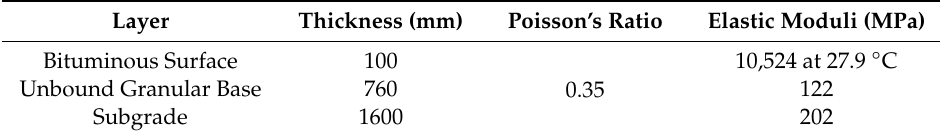
Figure 4. On-site installation of sensors in the pavement structure. Table 1. Pavement structure back-calculation modulus.